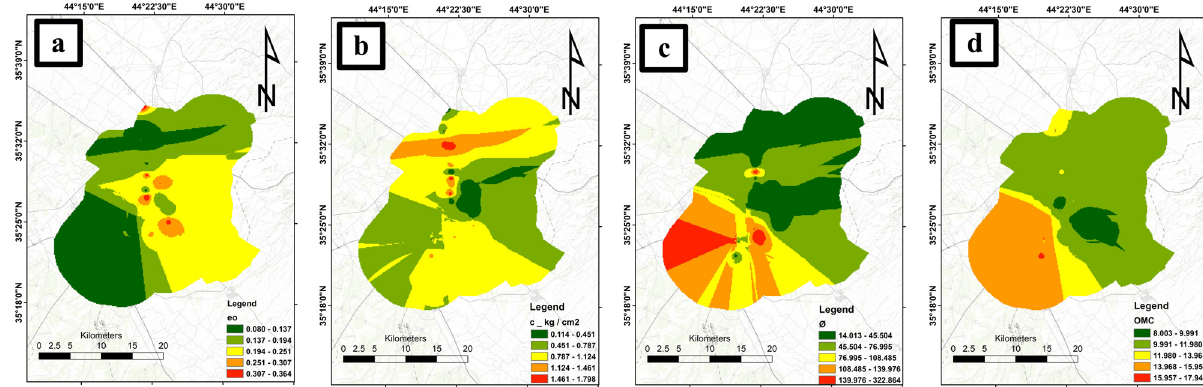
Figure 4: IDW representation of various soil characteristics distribution in Kirkuk city: ( a ) e o , ( b ) c ( kg/cm 2 ) , ( c ) ϕ , and ( d )